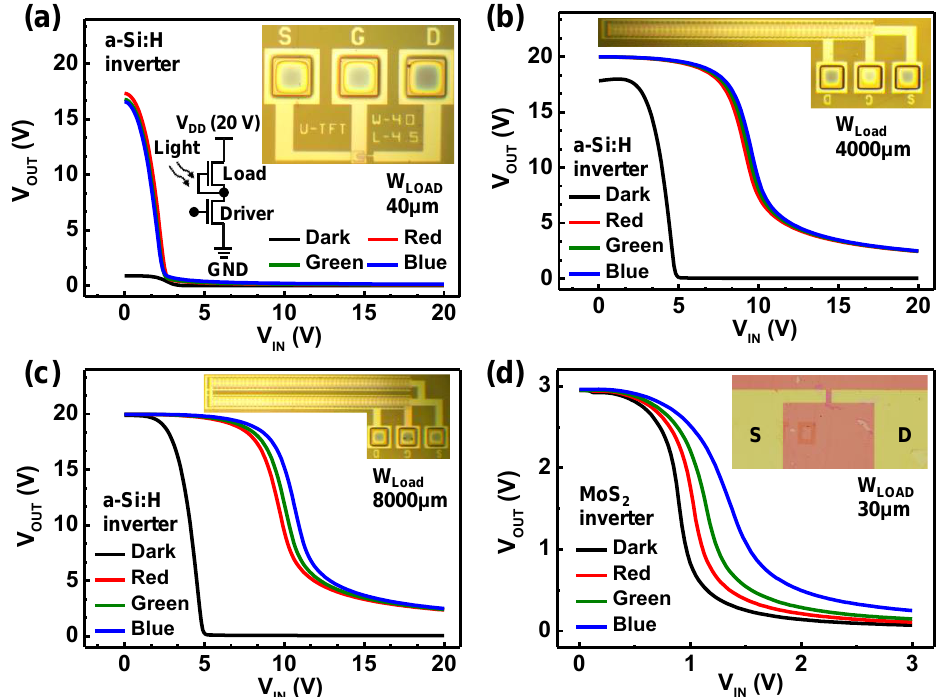
Figure 5. Voltage transfer characteristics of a-Si:H DLED inverters with ( a ) 40 μ m, ( b ) 4000 μ m, and ( c ) 8000 μ m of W load under illumination from dark to blue. ( d ) Voltage transfer characteristics of m-MoS 2 DLED inverters with 30 μ m W load . Insets show optical image of a-Si:H and m-MoS 2 TFTs with each channel dimension.